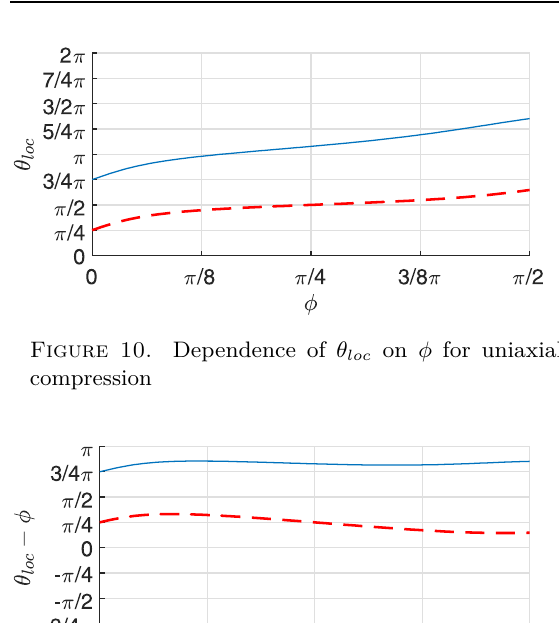
loc and φ as a func-